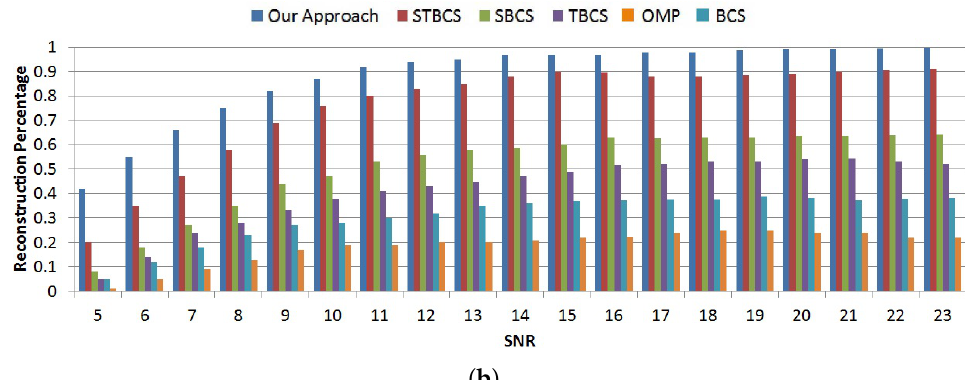
Figure 13. ( a ) Reconstruction accuracy percentage for different compression ratios. ( b ) Reconstruction accuracy percentage for different SNRs.